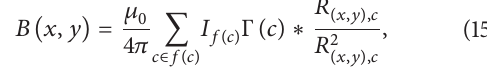
The black curve represents object boundary, the green + denotes magnetic field from object boundary going per- pendicularly into the image plane, and the green ∙ denotes the magnetic field coming perpendicularly out of image plane, while the blue arrows represent the magnetic forces with vertical directions to the false active contour, which is denoted with a red